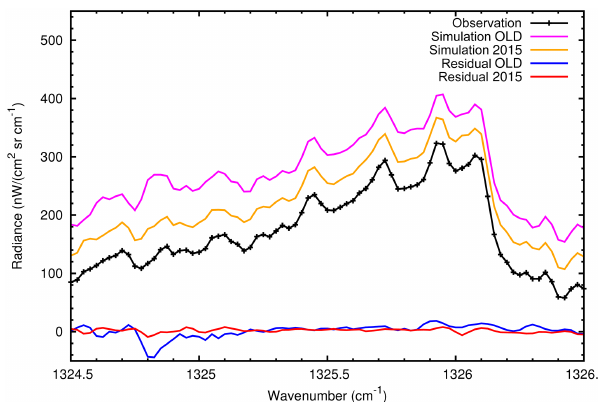
Figure 4. Average MIPAS-observed spectrum (black) in the 1324.5–1326.5cm − 1 spectral region, and simulated spectra with the MIPAS-OLD (magenta line) and the MIPAS-2015 (orange line) HNO 3 linelists. For better readability of the plot, the average orange and magenta lines were shifted by 50 and 100nW ( cm 2 srcm − 1 ) − 1 respectively. The blue and the red lines are the residuals obtained with the MIPAS-OLD and the MIPAS-2015 linelists